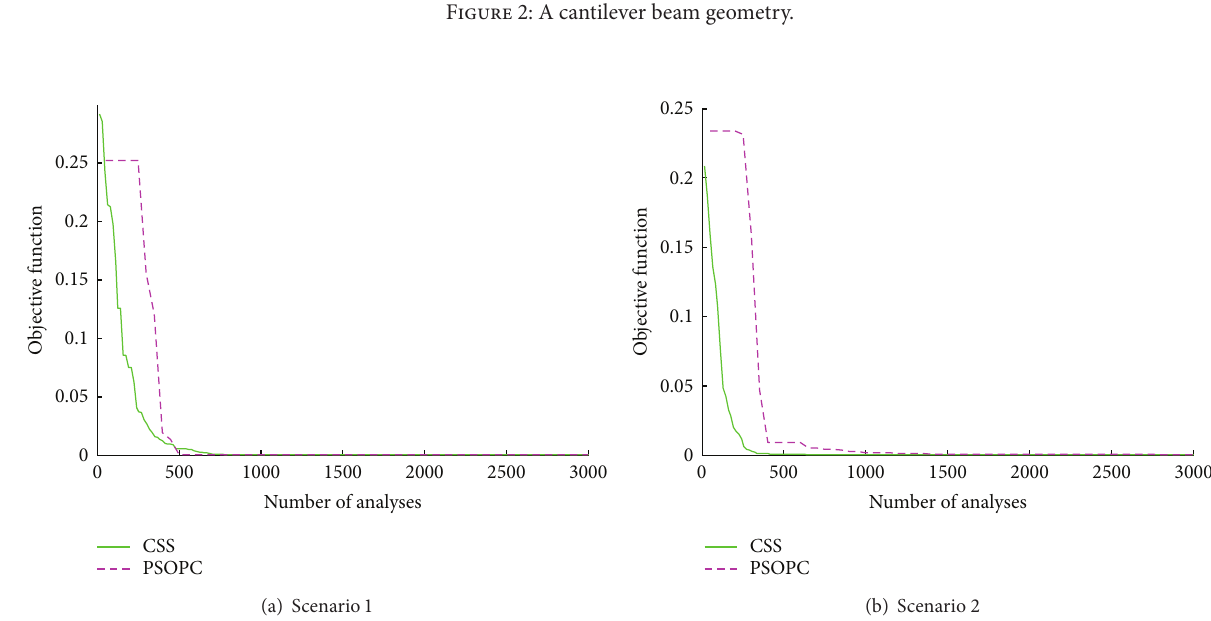
Figure 2: A cantilever beam geometry.